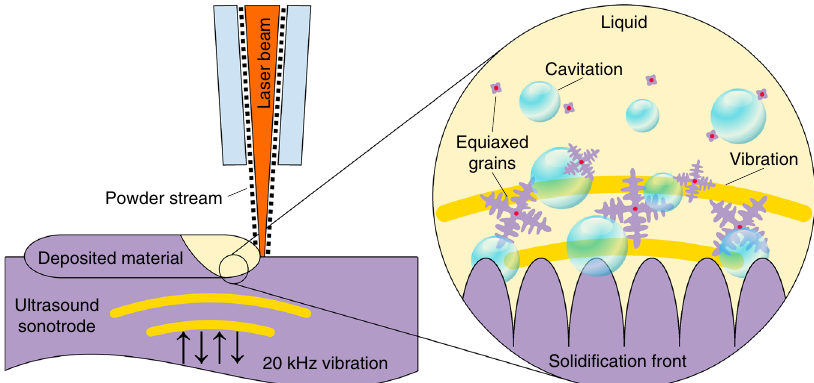
Fig. 1 High-intensity ultrasound during metal AM. Cross-sectional schematic showing metal AM by laser-based DED onto an ultrasound sonotrode vibrated at 20 kHz. The formation of acoustic cavitation and streaming in the liquid metal by high-intensity ultrasound can vigorously agitate the melt during solidi fi cation, thereby promoting signi fi cant structural modi fi cation or re fi